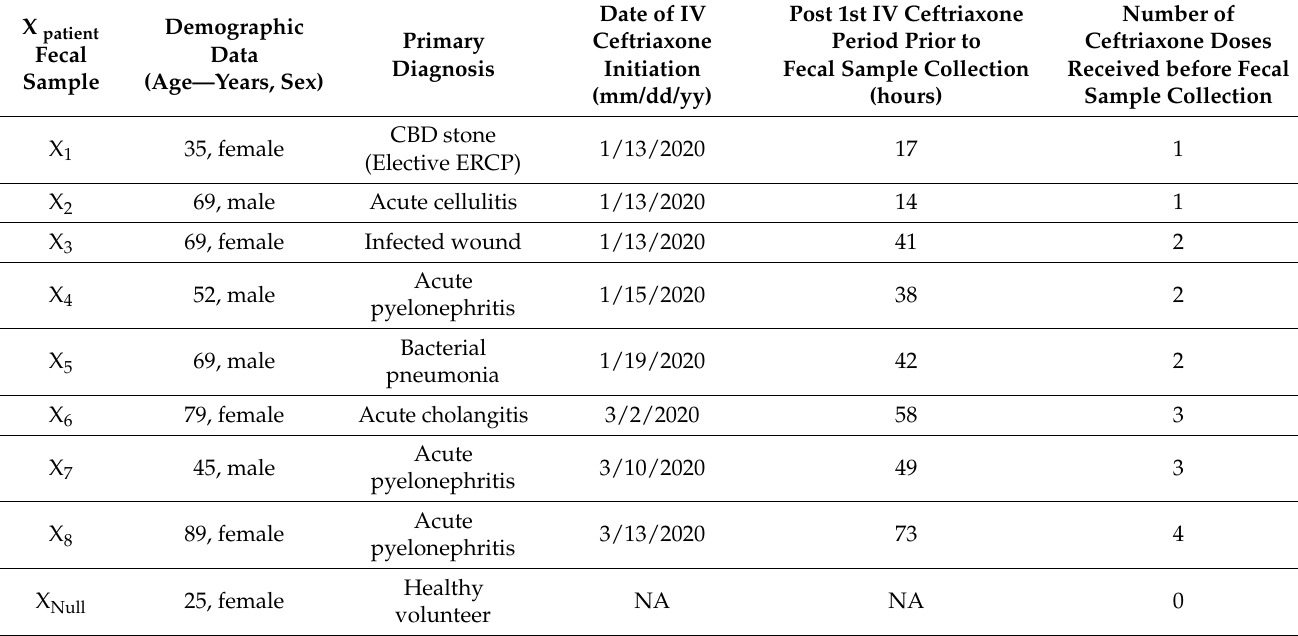
Table 1. Demographic and clinical characteristics of study